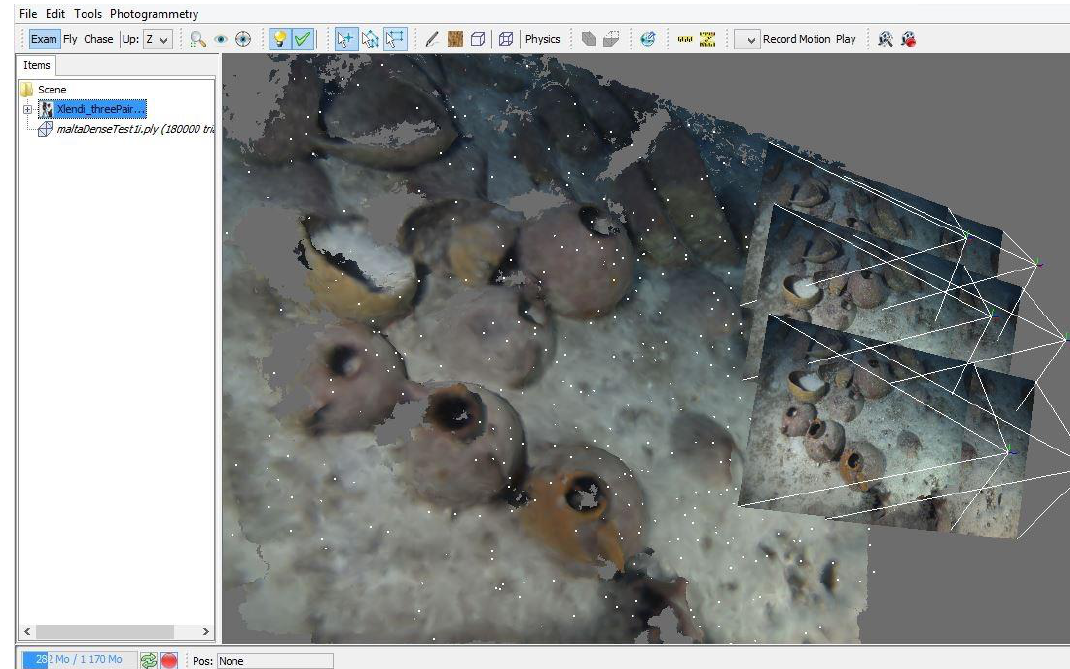
Figure 9. Three consecutive stereo pairs, oriented using the bundle adjustment approach described above, with a local densification of the original images. The visualisation is done inside the 3D tool developed by LSIS lab as a part of the Arpenteur project.